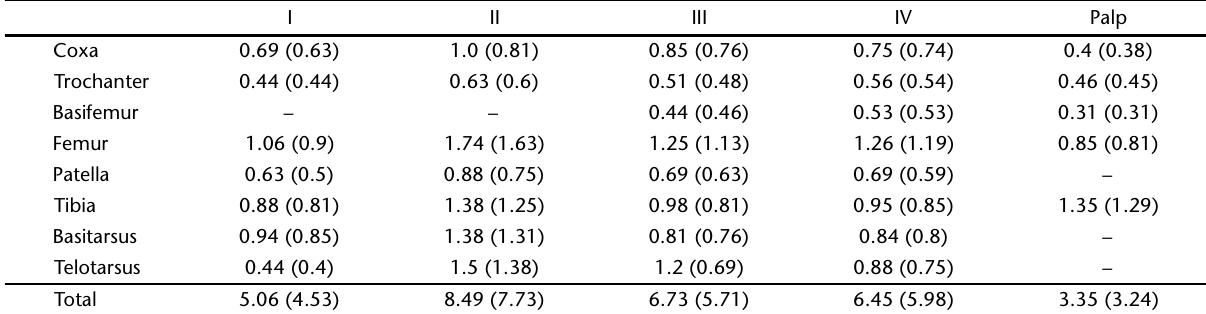
Table I. Cryptocellus cang a sp. nov . Measurements of male holotype and female paratype (MZSP 46555),